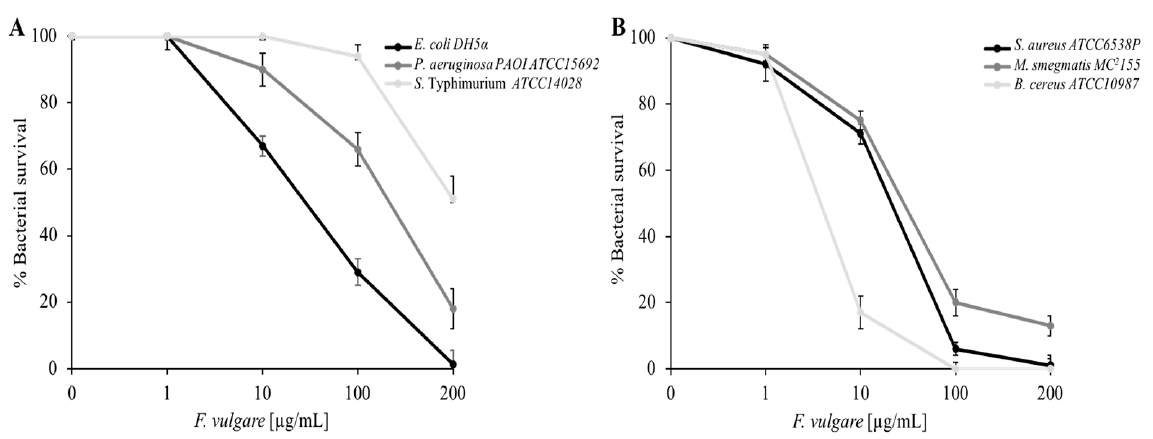
Figure 3. Determination of the F. vulgare subsp. vulgare var. vulgare EO antimicrobial activity at different concentrations evaluated by colony counting assay ( A , B ). The % Bacterial survival is represented on the y-axis obtained from the ratio of colony counts of treated and control. The assays were performed in three biological replicates; standard deviations are always less than 10%.